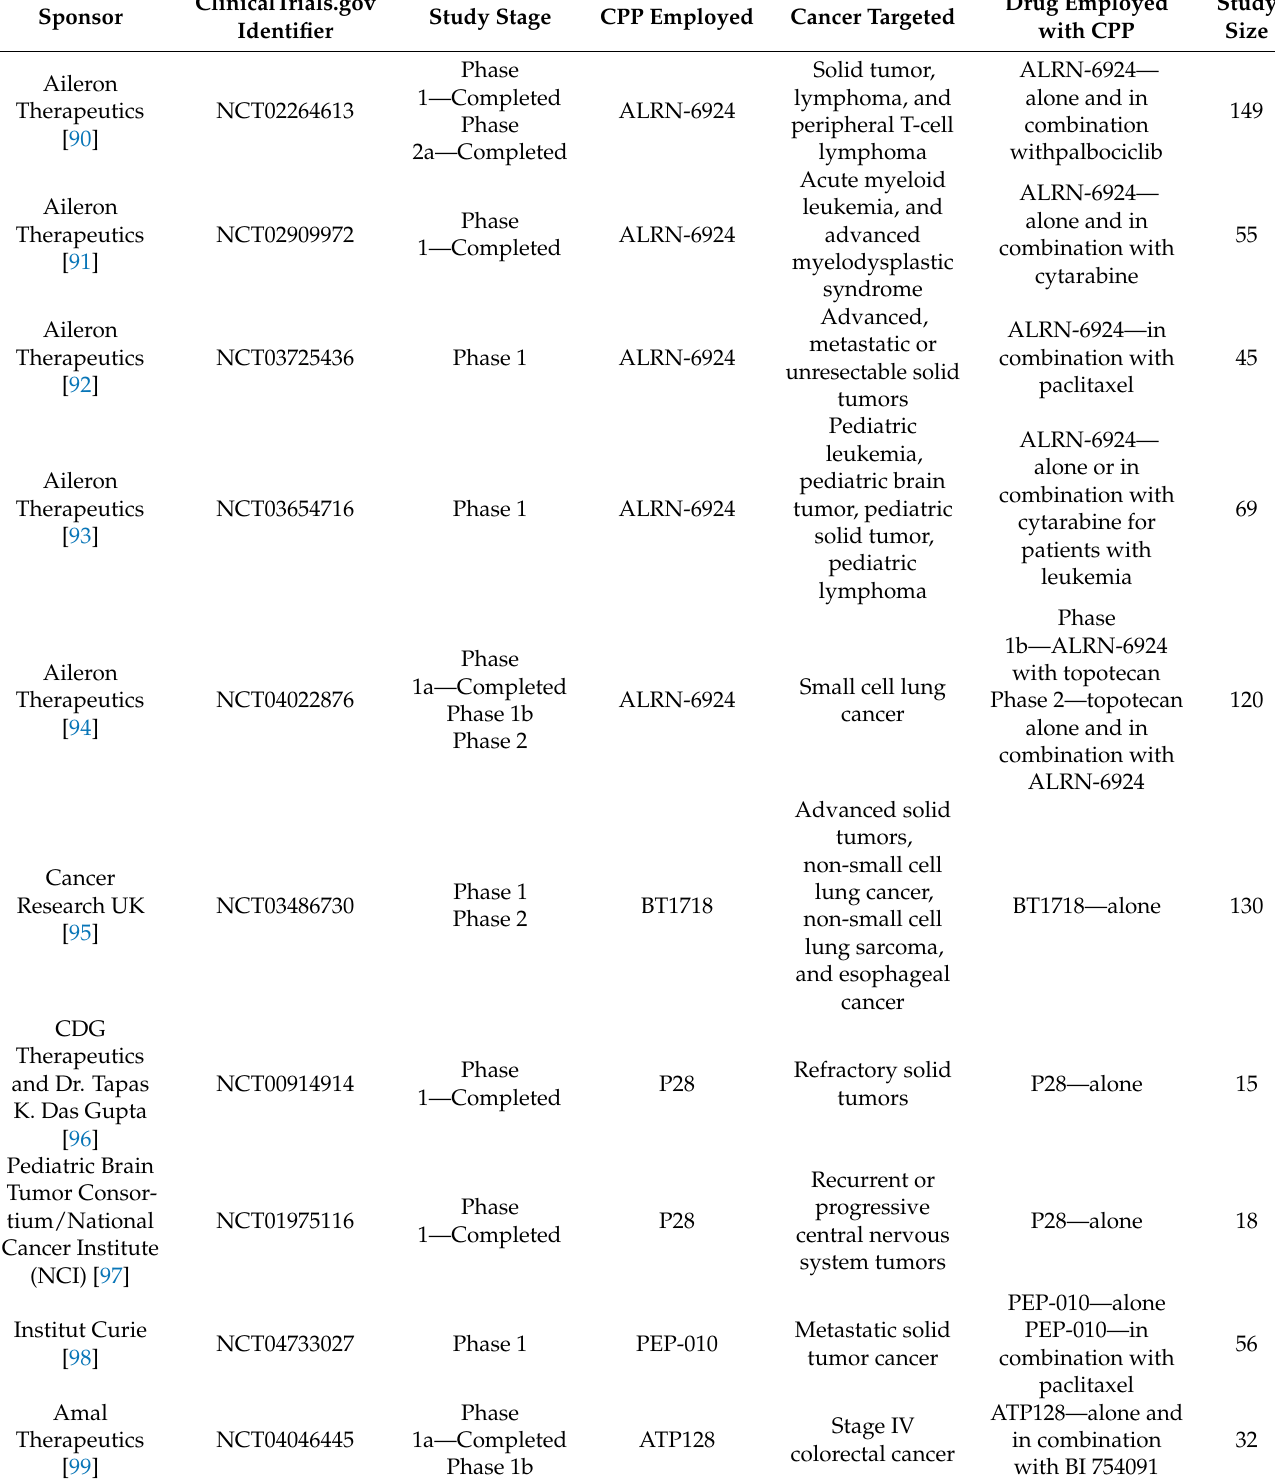
Table 1. Summary of various clinical trials utilizing CPPs in anticancer